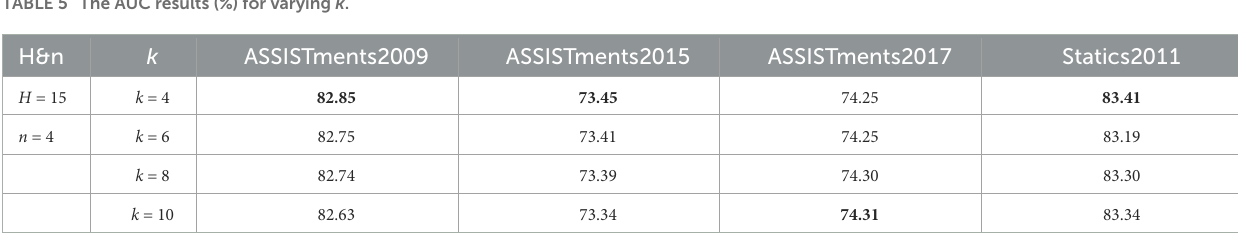
TABLE 5 The AUC results (%) for varying k .